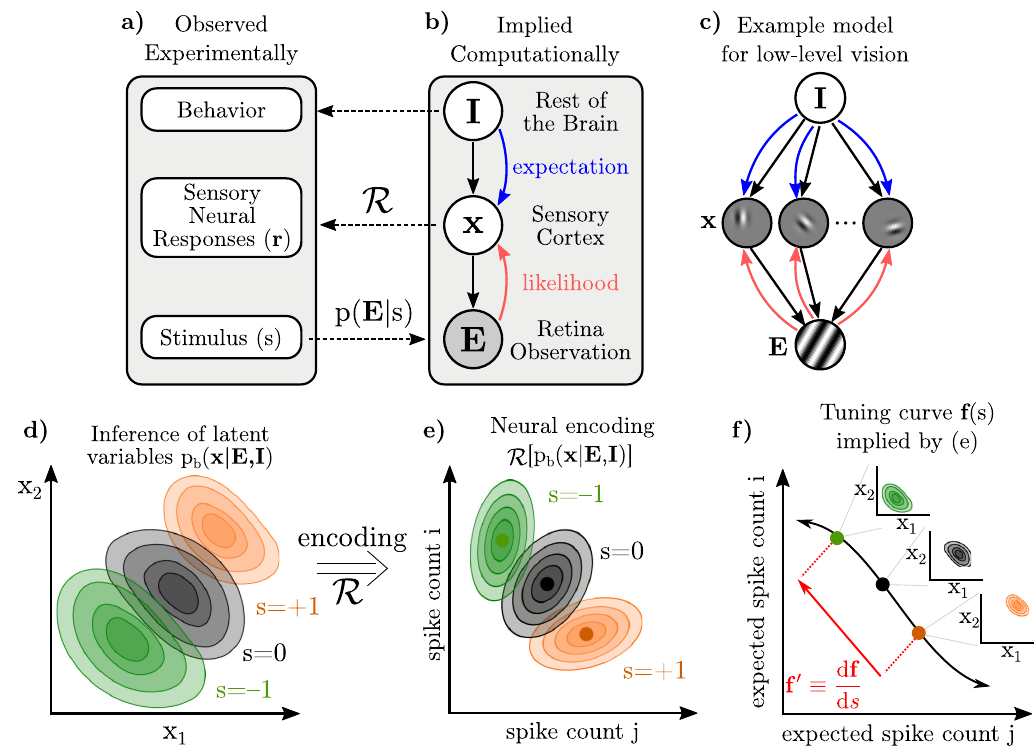
Fig 1. Illustration of the components of our framework and how they relate to experimentally observed quantities. a-b) The experimenter varies the sensory evidence, E , (e.g. images on the retina) according to s (e.g. orientation). The brain computes p b ( x | E , I ), its beliefs about latent variables of interest conditioned on those observations and other internal beliefs. I denotes these other “internal state” variables that are probabilistically related to, and hence form expectations for x . c) Here, we have illustrated x as Gabor patches which combine to form the image [72, 73], but our results hold independent of the nature of x . Solid black arrows represent statistical dependencies in the brain’s implicit generative model, while red and blue lines show information flow. Dashed lines cross levels of abstraction. d) Varying a stimulus, s , such as the orientation of the grating image in (c), results in changes to the posterior over latent variables in the brain’s internal model, but these distributions on x cannot be directly observed. e) The recorded neurons are assumed to encode the brain’s posterior beliefs about x as in panel (d) through a distributional representation scheme, R , which is a hypothesized map from unobservable distributions over x to observable distributions of r . We denote this map as R ½ p ð x j E ; I Þ� [45]. Our derivation initially assumes only that smoothly changing b posteriors (d) correspond to smooth changes in neural response statistics (e); other restrictions on R will be introduced later. f) Mean spike counts (or firing rates) as a function of some stimulus s define a tuning curve, f ( s ). Both the tuning curve, f ( s ), and its tangent at a point, f 0 , thus reflect, in part, changes in the underlying posterior over x (insets).